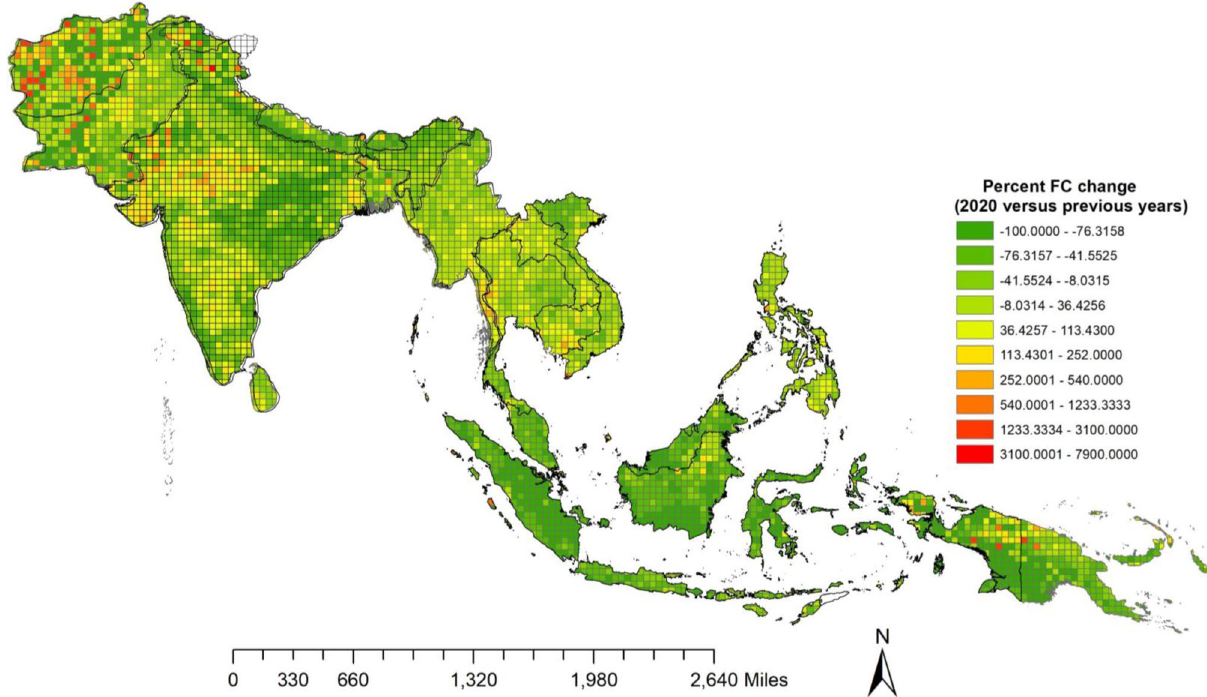
Figure 5. Percent FC change during 2020 versus previous years (2012–2020) for South/Southeast Asia. VIIRS I-band (375 m) fire counts were spatially gridded at 30 min intervals (0.5 × 0.5degree cells) for the regional scale analysis. A clear percent increase in fires can be seen in Afghanistan, Western Pakistan, northern Himalayan region, Central India extending towards south, southern Laos, western Cambodia, Philippines, northern Kalimantan and Papau New Guinea, Indonesia (Map created using QGIS